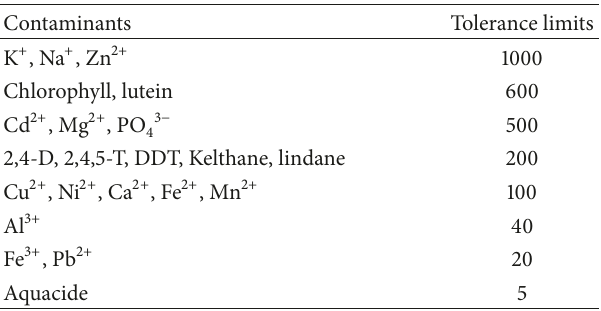
Table 1: Effect of contaminants for detecting 40 𝜇 g/L PQ.